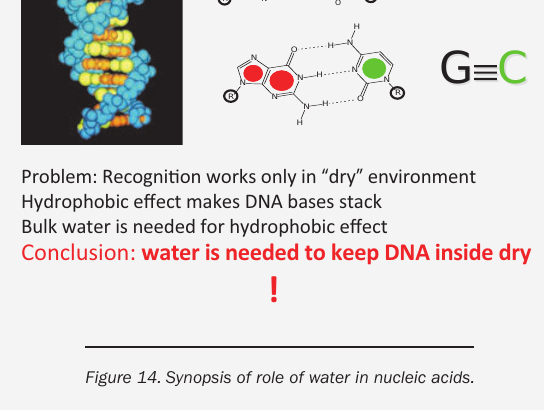
Figure 14. Synopsis of role of water in nucleic